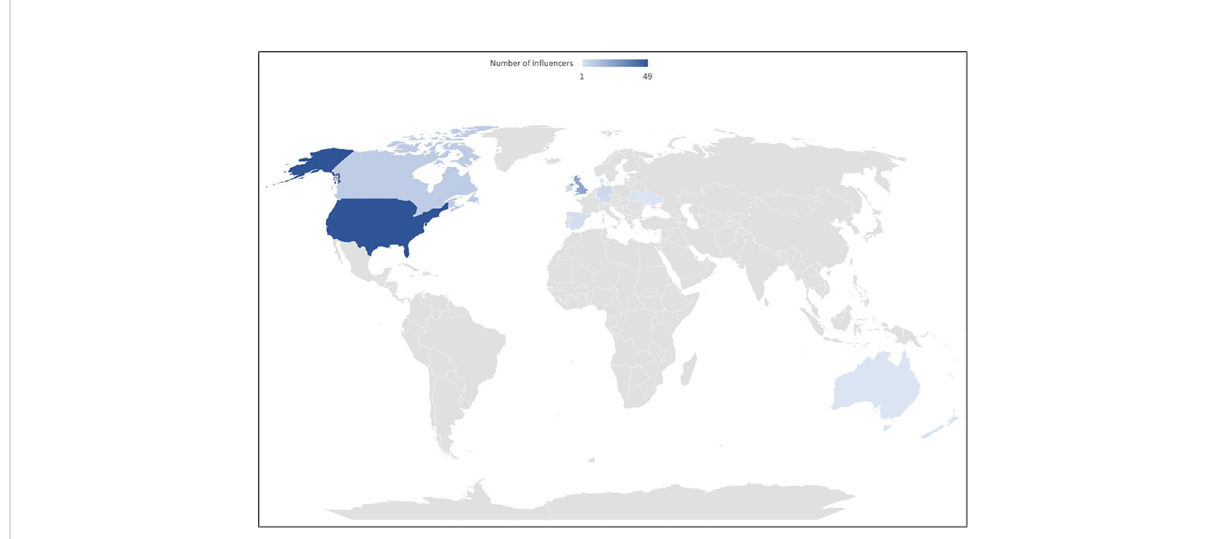
FIGURE 1 Geographic spread of top 100 in fl uencers for PCOS. The world map is for diagrammatic representation only and doesn't purport to be the political map of any